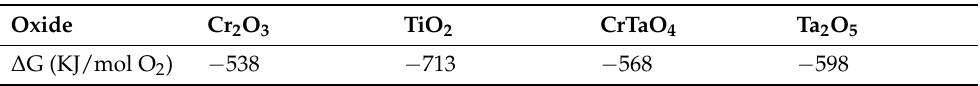
Table 4. Standard Gibbs free energy of metal oxidation products of Cr, Ta, and Ti at 800 °C . Oxide